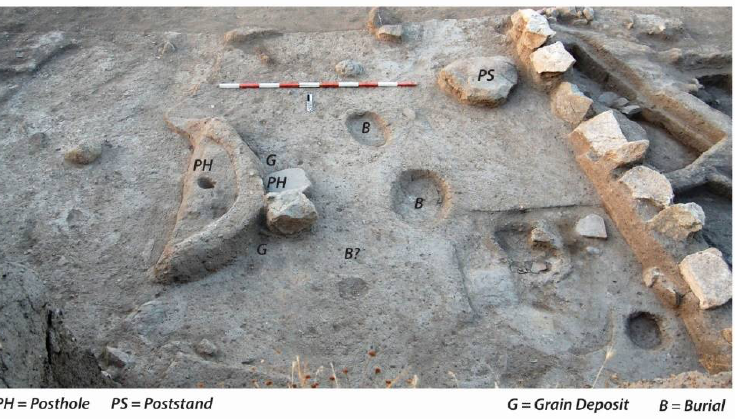
Figure 11. Photo of the semi-circular mudbrick construction in the Non-Domestic Building with the associated burials and features described in the text.